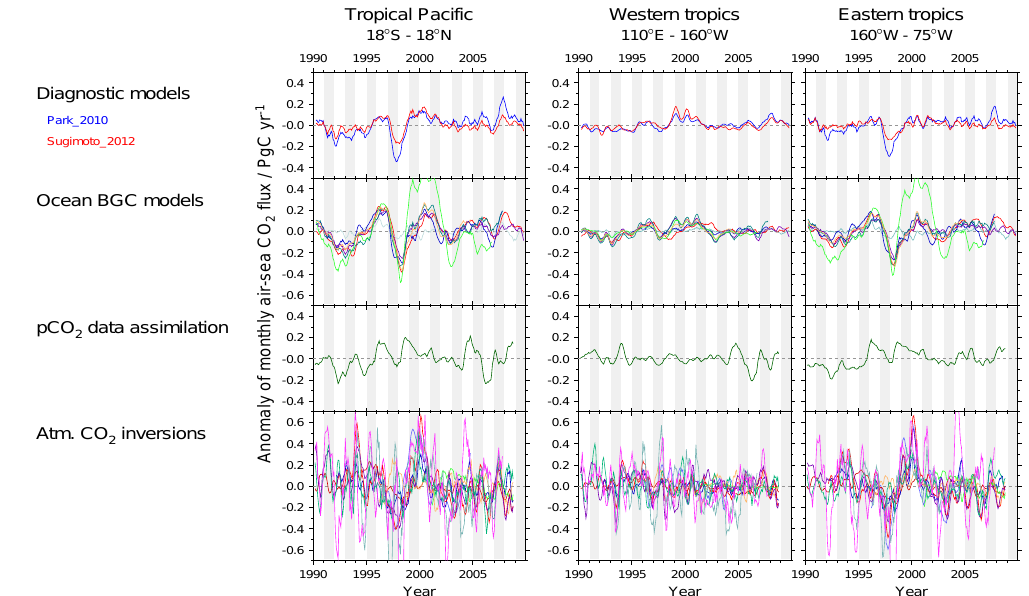
Fig. 7. Trend of air–sea CO 2 flux anomalies (5-month running means) in the tropical Pacific (18 ◦ S–18 ◦ N) (left panel) for 1990–2009, and its components in the western tropical sector to the west of 160 ◦ W (middle) and in the eastern tropical sector to the east of 160 ◦